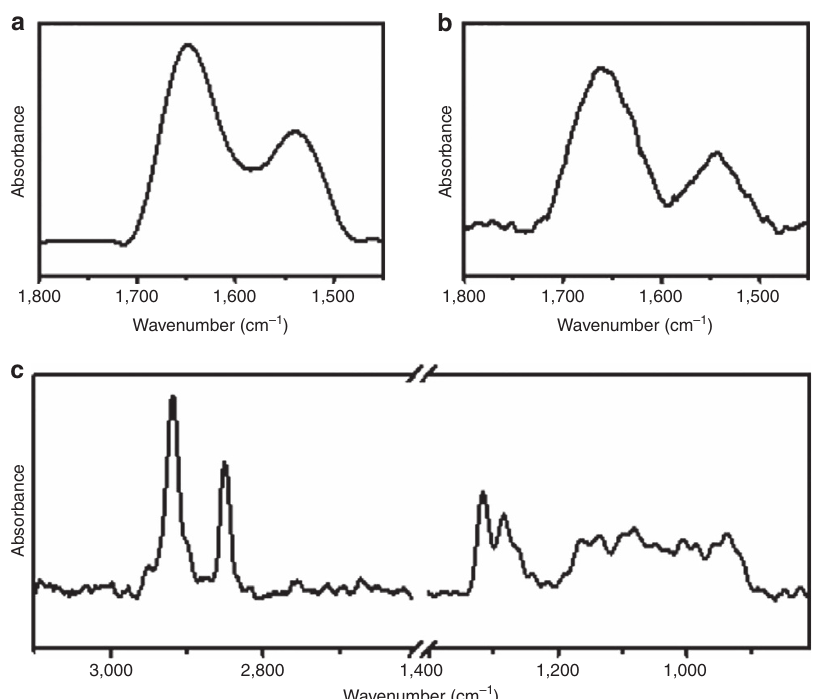
Figure 8 | GATR-FTIR spectra of the adsorbed monolayers. ( a ) NH 2 -{Ala-Aib} 8 -COCHNH 2 CH 2 PO 4 H 2 , ( b ) SHCH 2 CH 2 CO-{Ala-Aib} 5 -COOH, and ( c ) 11-mercaptoundecylphosphoric acid monolayers adsorbed on